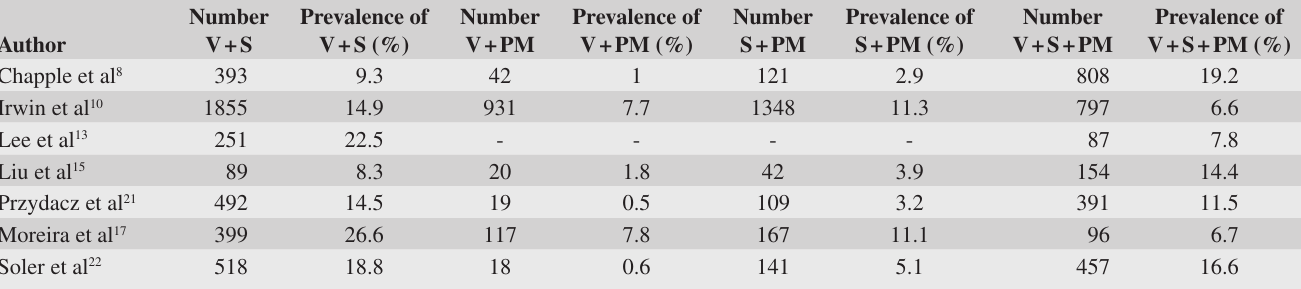
Table 4. The prevalence of combined voiding, store and post-micturition